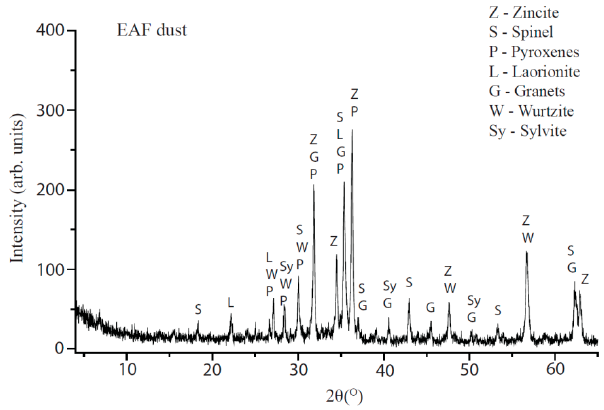
Figure 2. XRD analysis of the EAF dust.